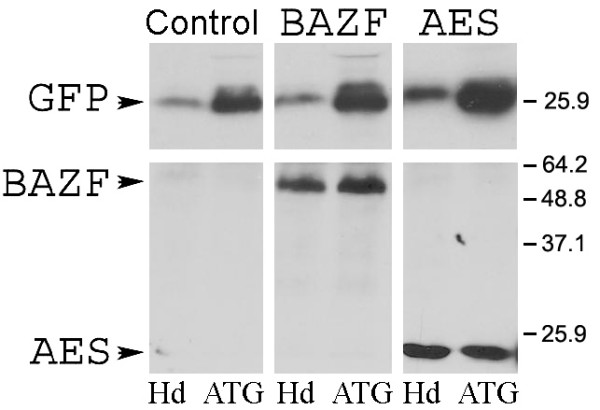
Western blot analysis of HEK 293T cell lysates. Cells were transfected with pMigR-Hd and pMigR-ATG (Control), or pMigR-Hd-BAZF and pMigR-ATG -BAZF (BAZF), or pMigR-Hd-AES and pMigR-ATG-AES (AES). Hd: pMigR-Hd based vectors, ATG: pMigR-ATG based vectors. GFP, BAZF and AES: translation products of the corresponding cDNAs. Molecular weight markers are indicated.